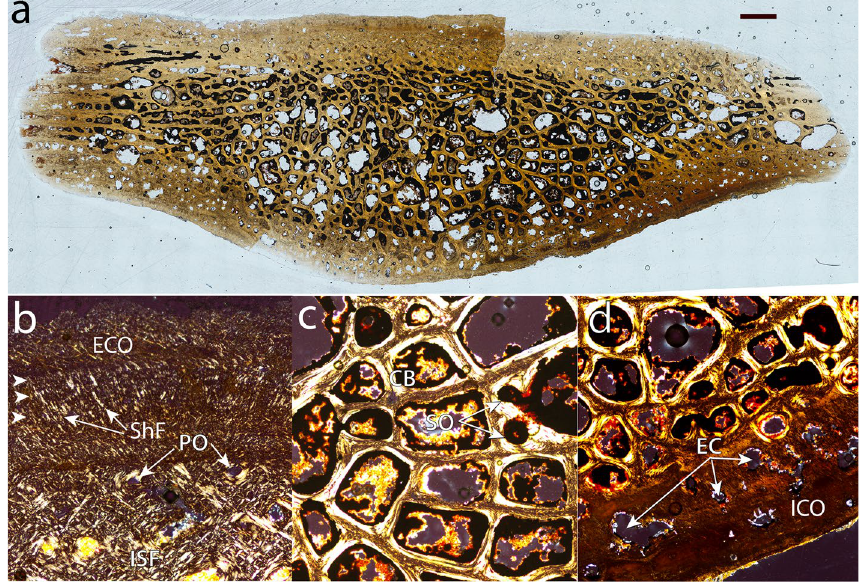
Figure 5. Thin section of DMNH 2013-07-0525, a probable left costal 4 of Pleurochayah appalachius gen. et sp. nov., from the Cenomanian (Upper Cretaceous) of the Arlington Archosaur Site (Lewisville Fm, Woodbine Gp), shown in normal transmitted ( a ) and linear-polarized light ( b – d ). CB cancellous bone, EC erosion cavity, ECO external cortex, ICO internal cortex, ISF interwoven structural collagenous fibre bundles, PO primary osteon, ShF Sharpey’s fibers, SO secondary osteon. Arrowheads in ( b ) indicate lamellae. Scale bar in ( a ) 1 mm; other figure parts not to